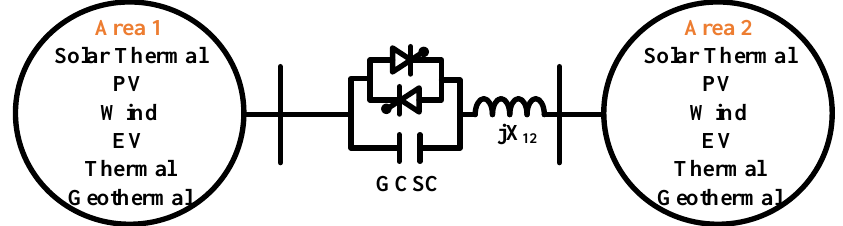
Figure 10. GCSC arrangement in the series of the transmission line. Table 9. Cascaded PID-FOPID controllers’ gain for SMES-SMES coordination.